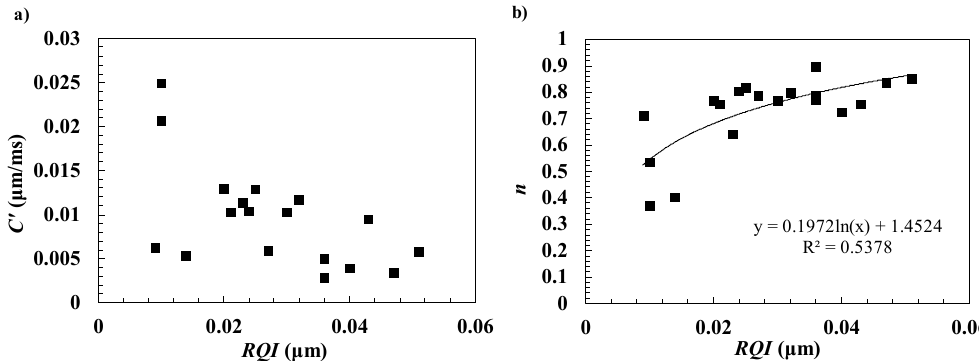
Figure 12. The correlation between nonlinear conversion parameters and reservoir quality index (RQI) of core plugs: ( a ) the correlation between the nonlinear conversion coe ffi cients C (cid:48) and RQI of core plugs; ( b ) the correlation between nonlinear conversion exponents n and RQI. Table 4. The obtained nonlinear conversion coe ffi cient C (cid:48) and exponent n .